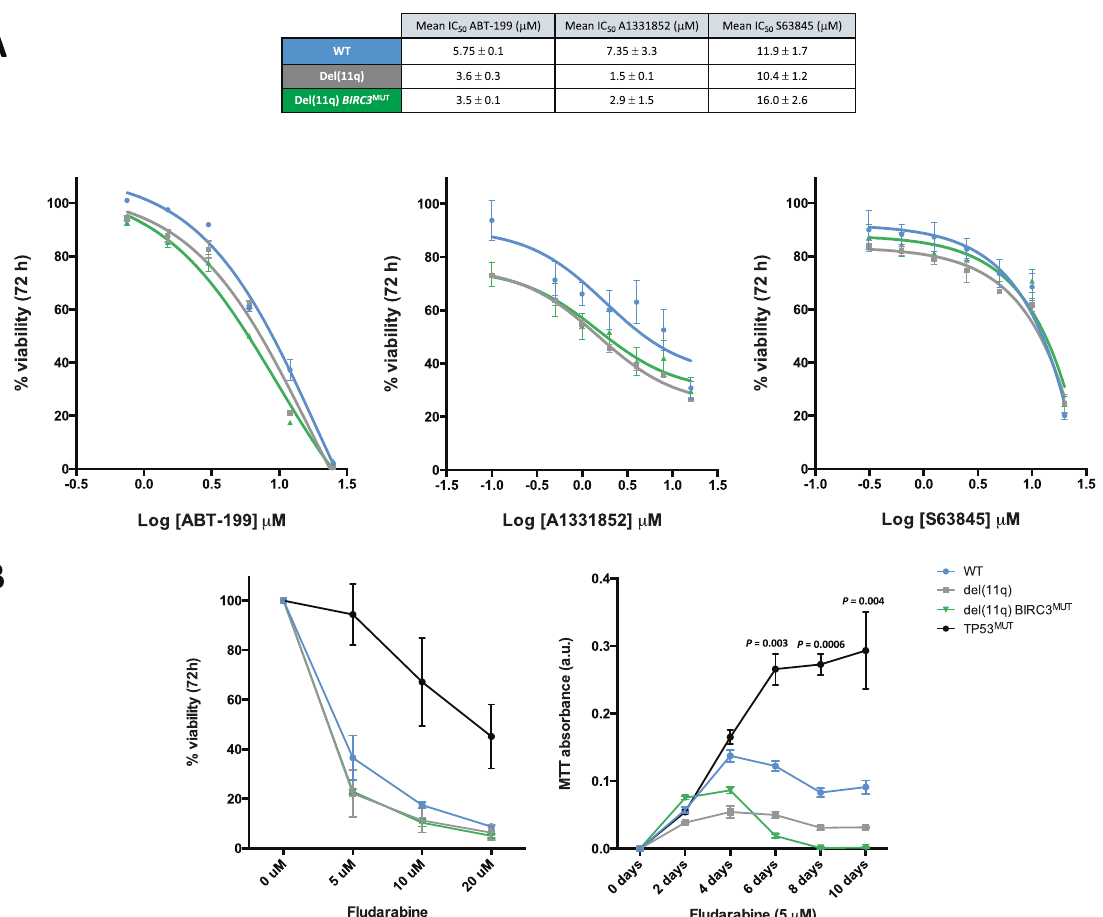
Fig. 4 Cell viability studies of del(11q)/ BIRC3 -mutated cell lines in response to BCL2, BCL-xL, MCL1 inhibition, or fl udarabine treatment. A Dose-response curves of HG3 WT , HG3-del(11q) and HG3-del(11q) BIRC3 MUT clones treated with venetoclax (ABT-199; BCL2 inhibitor, left panel), A1331852 (BCL-xL inhibitor; middle panel) and S63845 (MCL1 inhibitor, right panel). Cell viability was assessed by MTT assay after 72 h and surviving fraction is expressed relative to DMSO control. Data are summarized as mean ± SEM. B Left panel: HG3-edited clones were treated with escalating doses of fl udarabine and cell viability was assessed by MTT assay after 72 h. Surviving fraction is expressed relative to DMSO control. Data are summarized as the mean ± SD. Right panel: HG3-edited clones were treated with fl udarabine at a concentration